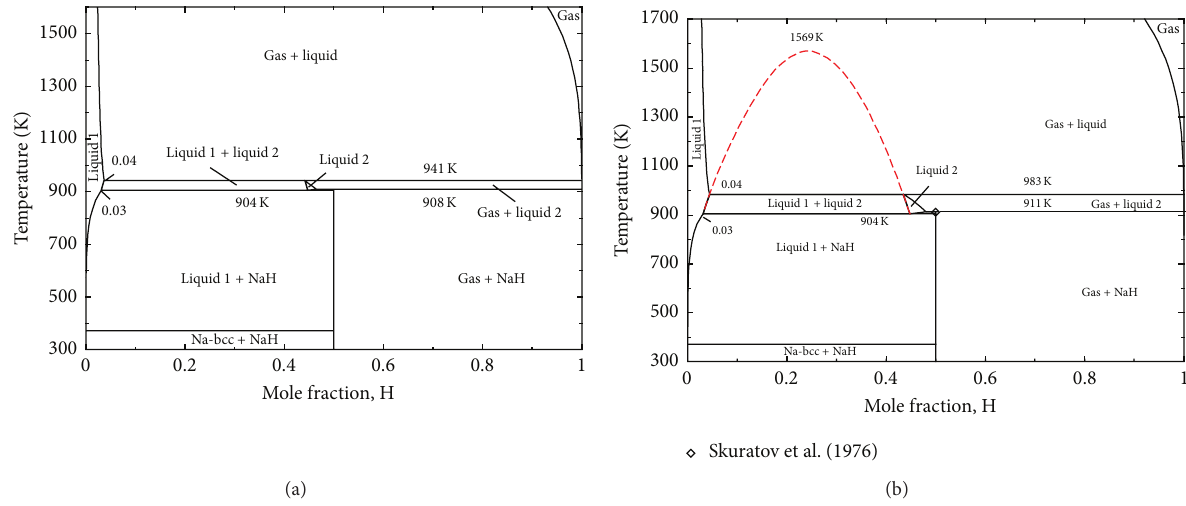
Figure 5: The Na-H phase diagram calculated at (a) 150 bar and (b) 200 bar showing the metastable immiscibility gap.